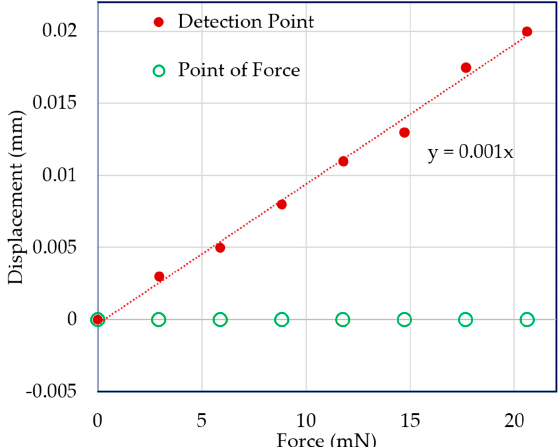
Figure 11. Displacements of the point of force and detection point with the addition of a unit force of 3 mN.